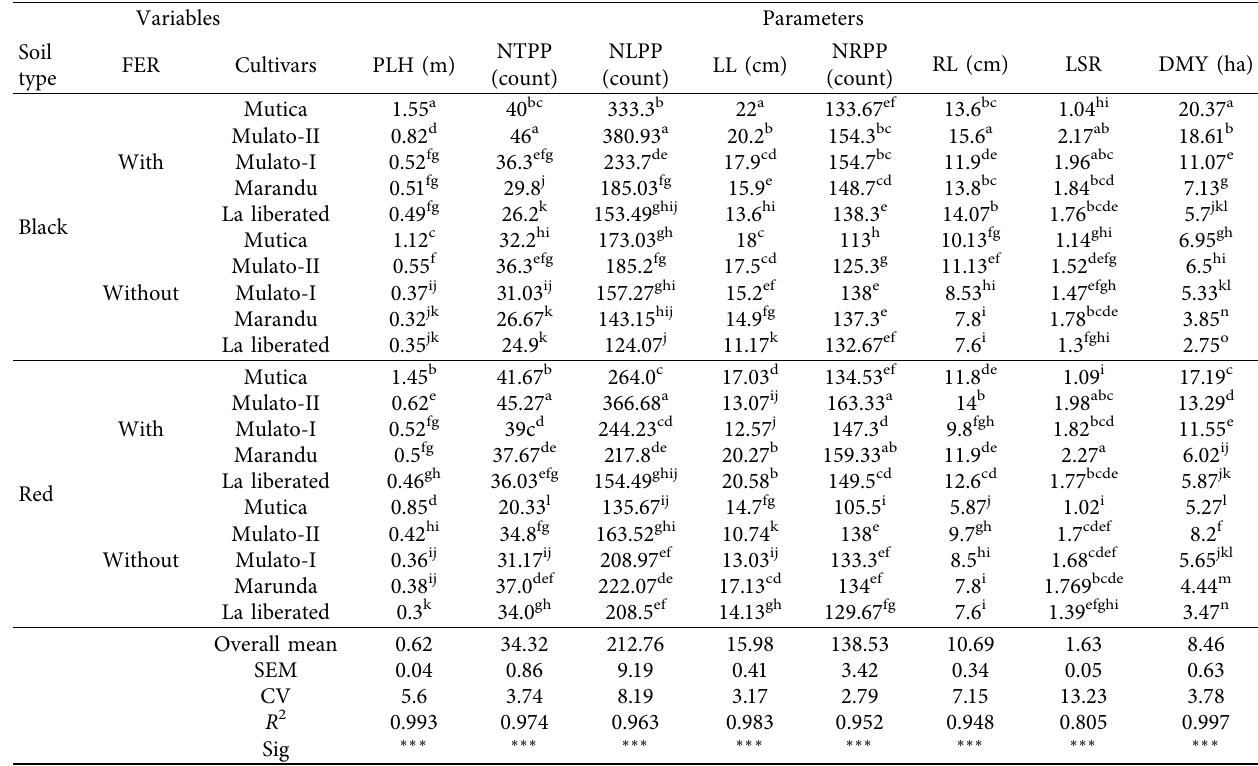
Table 2: Efect of fertilizer, cultivars type and soil type on morphological characteristics and forage yield of Brachiaria grasses.